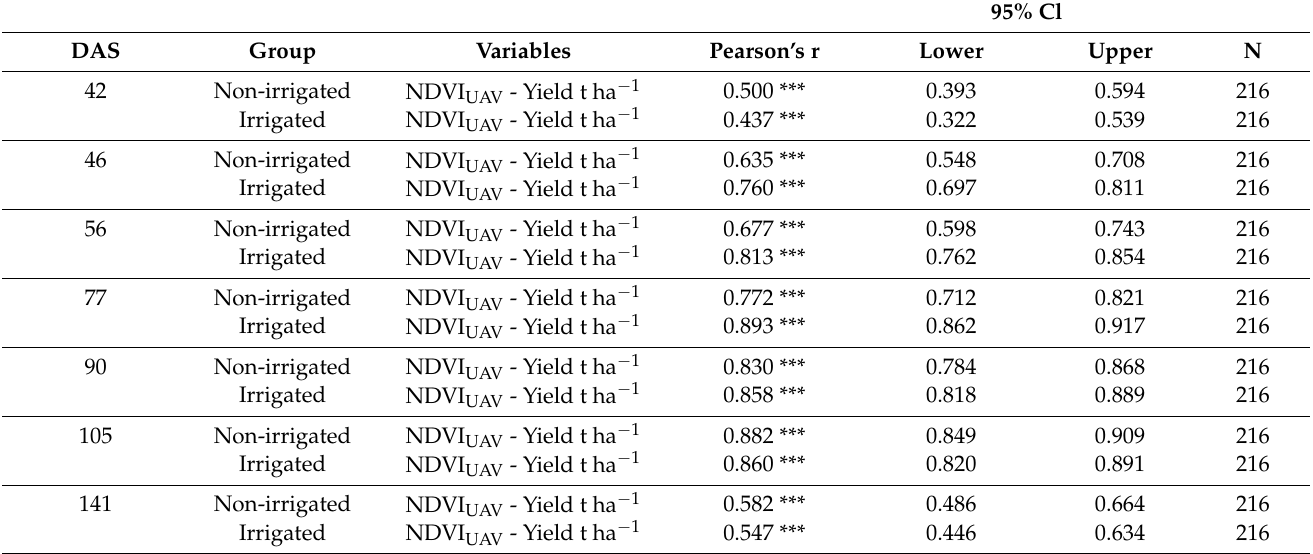
Table 3. Pearson correlation coefficient (r) values among NDVI UAV and yield t ha − 1 in non-irrigated and irrigated conditions (2021, Debrecen).